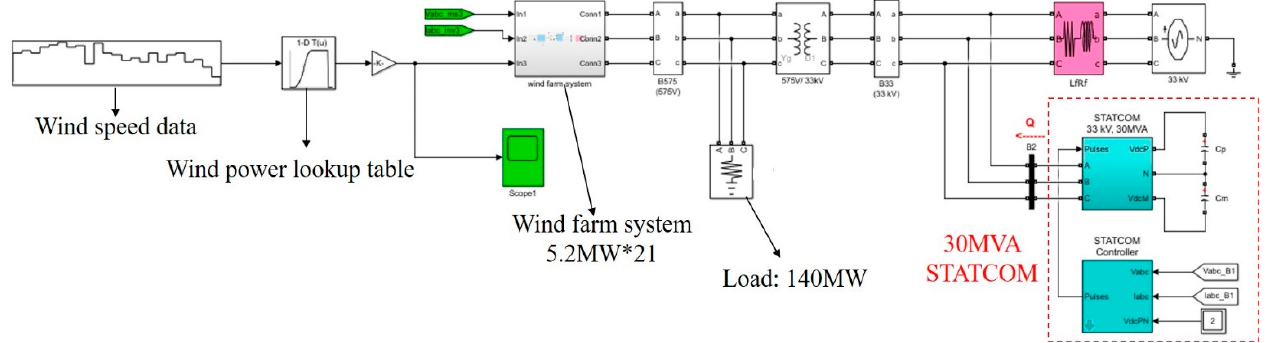
Figure 18. Simulink circuit model of the studied system.